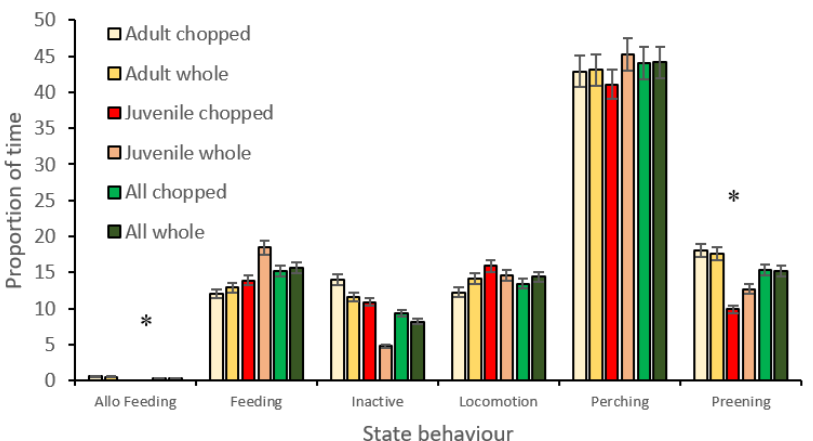
Figure 3. Activity budget for the adult, juvenile and all (adult and juvenile combined) White-cheeked Turacos when provided with either chopped or whole-food items (+/ − standard error). * indicates a significant difference ( p < 0.05). Table 4. Test outputs for comparisons of chopped and whole-food conditions. * indicates significant values ( p < 0.05)